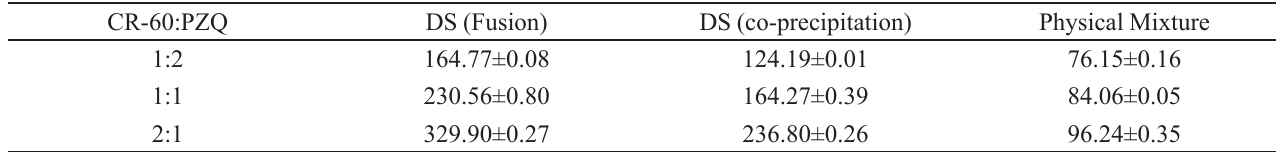
TABLE III - Effect of CR-60 on the solubility of PZQ ( × 10 -1 μg/mL) in buffered phosphate pH 7.4.